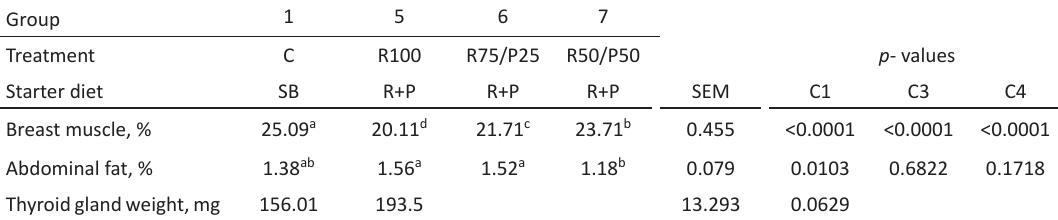
Table 7. The effect of diets with soybean meal (SB), rapeseed meal (R), or rapeseed meal and peas (P) on mean broiler breast muscle and abdominal fat percentages, and thyroid gland weight Group 1